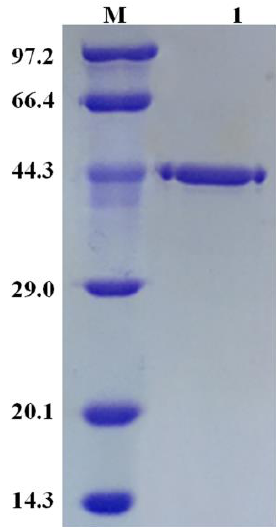
Figure 1. SDS-PAGE (12.5%) analysis of the purified recombinant ReCR. Lane 1, 2 µ g purified ReCR with C-terminal His-tag; lane M, molecular weight marker. Coomassie Brilliant Blue R-250 was used to visualize the protein bands in the SDS-PAGE gel.